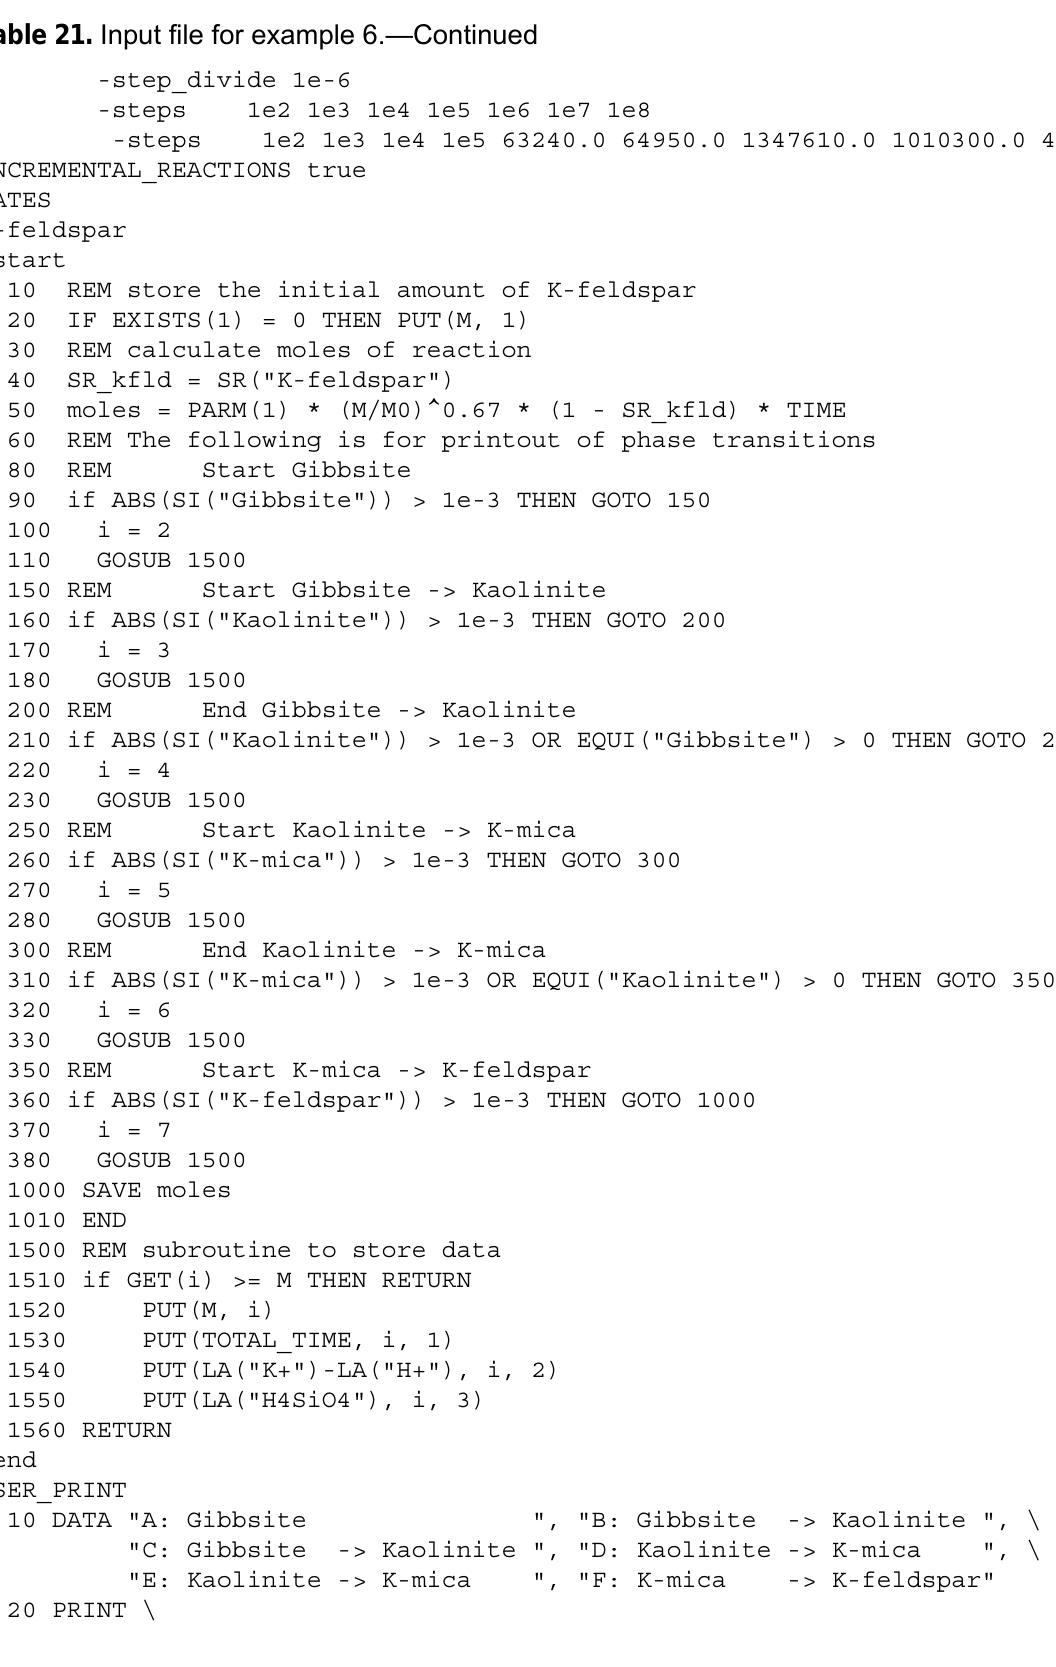
Table 21. Input file for example